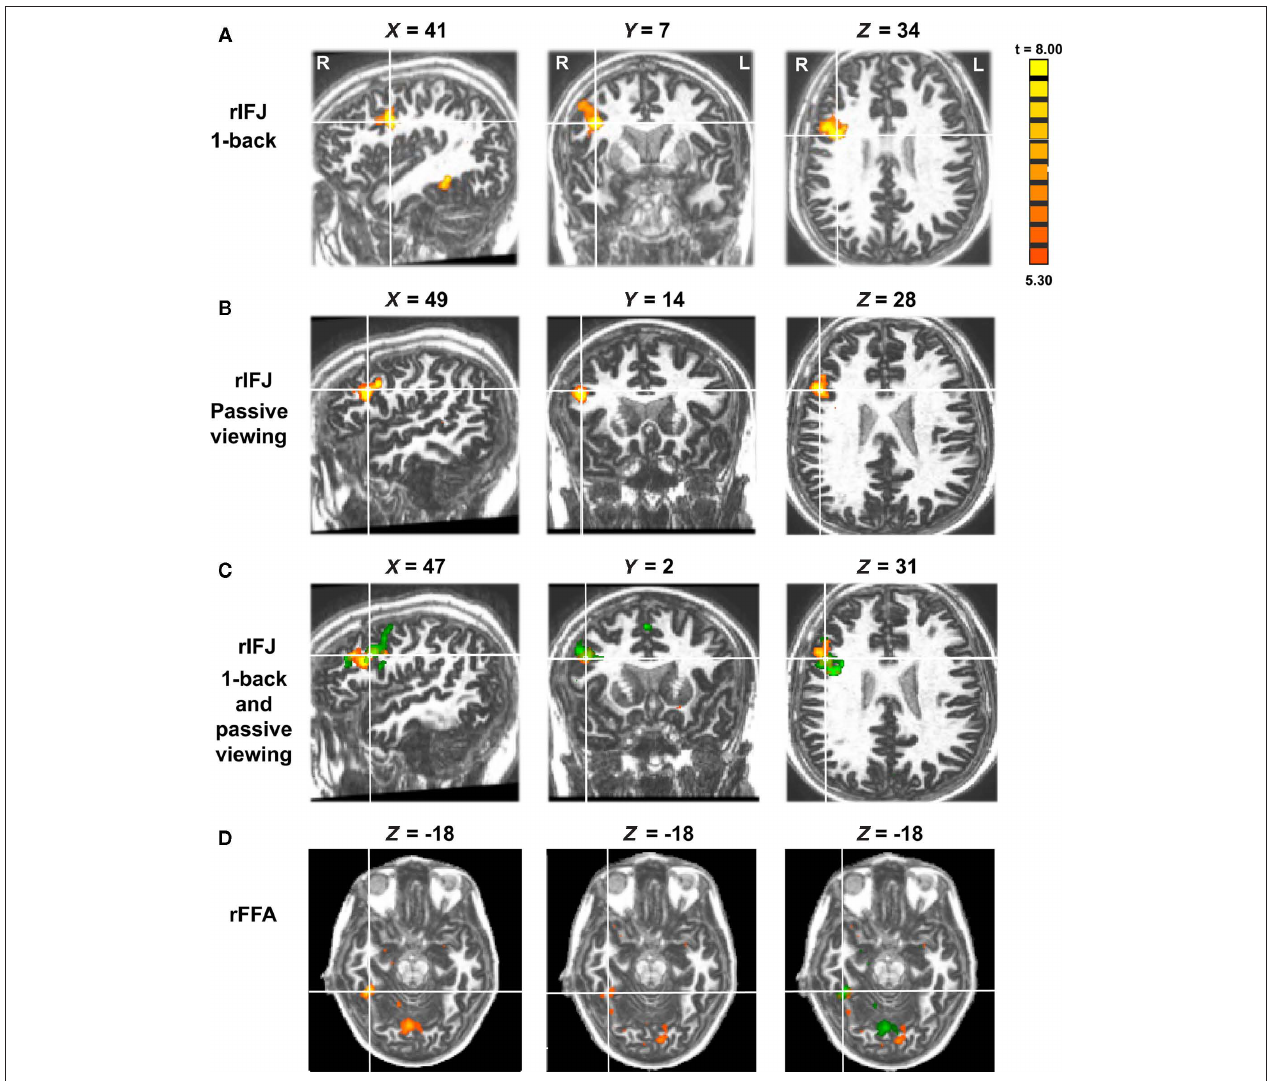
( p < 0.0001, t > 5.30). For comparison, panel (D) shows the FFA in the 1-back task (left), in the passive task (center), and the overlap between these activations (right). All regions are defined by the contrast of faces–tools ( p < 0.0005, t > 3.50). Axial slices at Z =